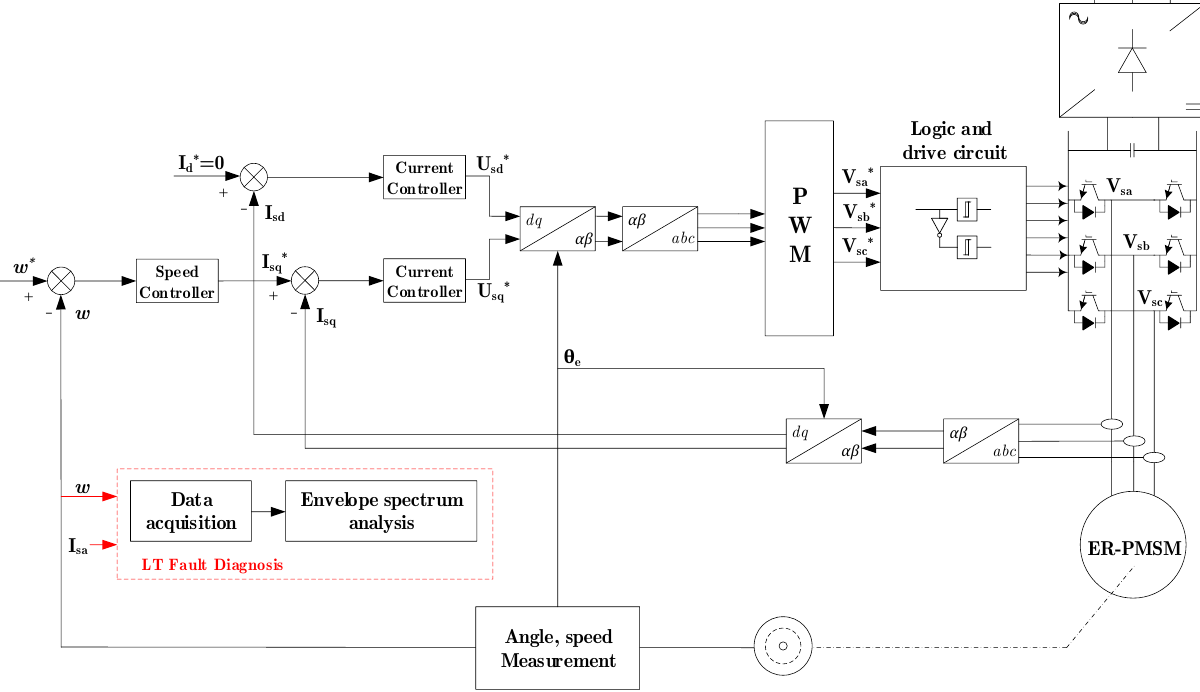
Figure 15. The flow chart of the proposed strategy.